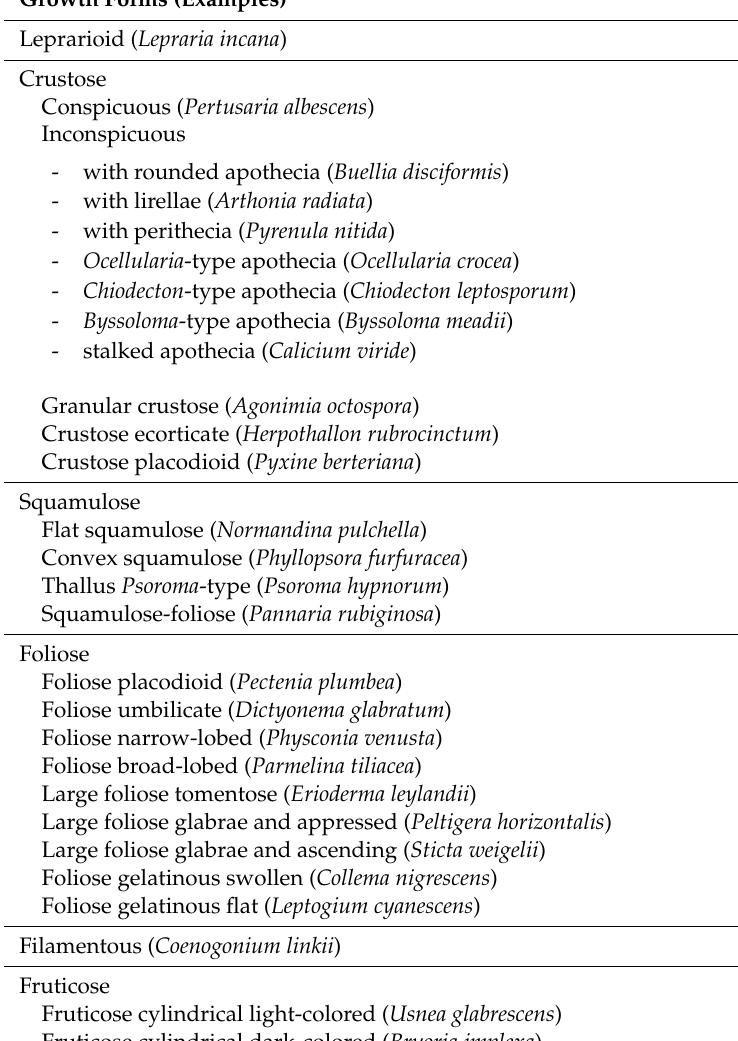
Table 2. List of growth forms of epiphytic lichens studied. A lichen species is included as an example of each growth